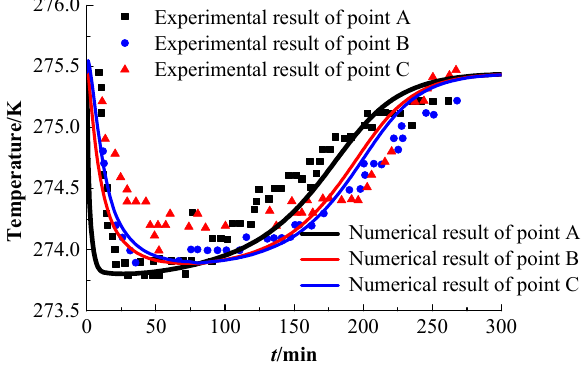
Figure 6. Comparisons of experimental and numerical results of the temperature at the three different positions A, B, and C of the sandstone core.